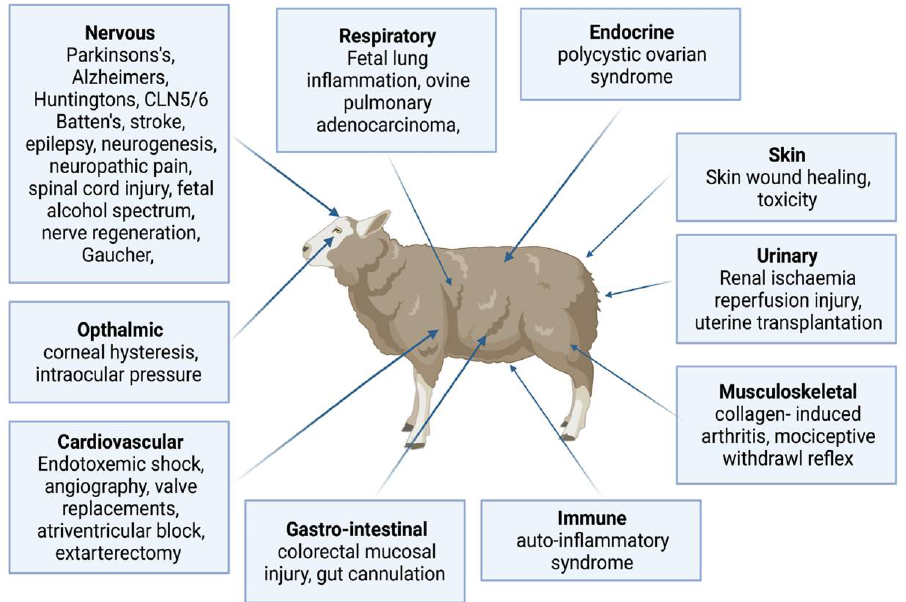
Figure 3. Sheep biomedical models for human physiology and diseases (Created with biorender.com accessed date 6 May 2022). The sheep is a large-experimental animal model to study normal